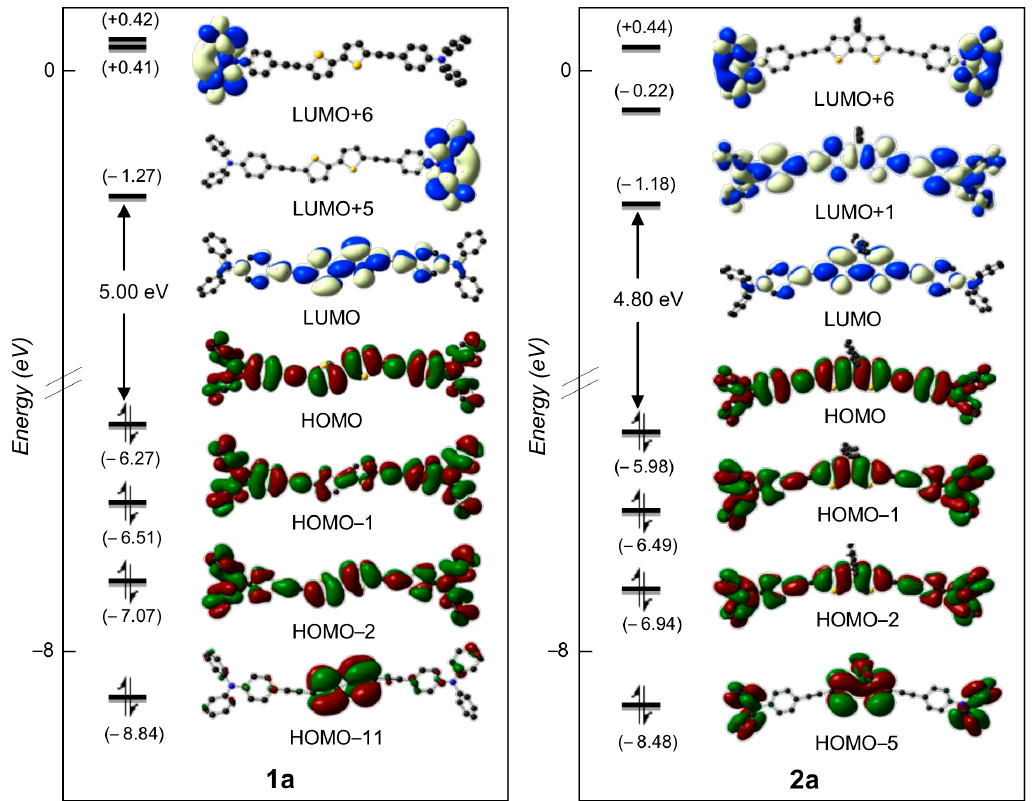
Figure 5. Frontier MO diagrams of 1a ( left ) and 2a ( right ) (contour isodensity values: ± 0.015 (e/bohr 3 ) 1/2 ). The hydrogen atoms are omitted for clarity.